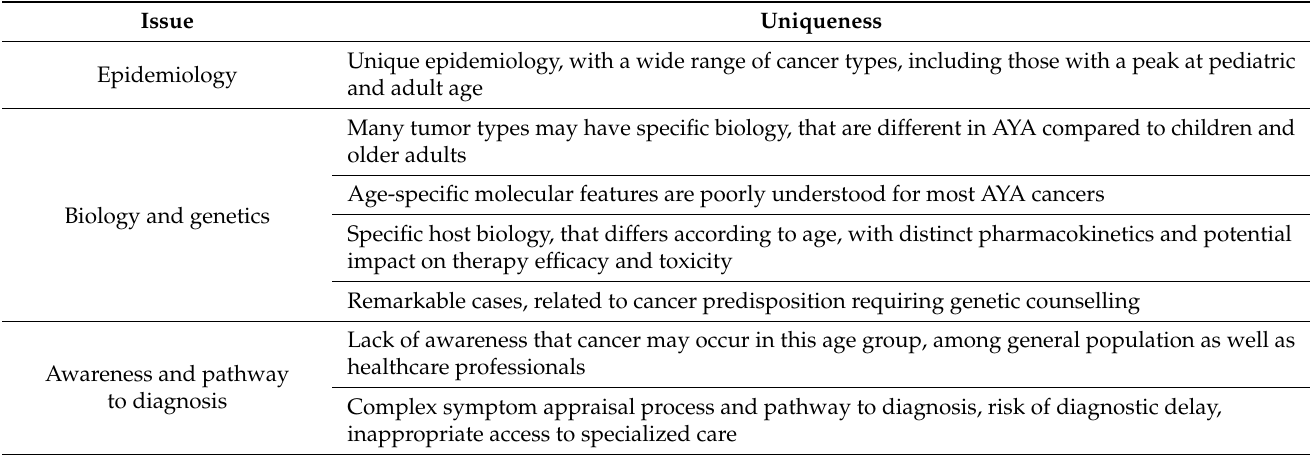
Table 1. Specific challenges of adolescents and young adults (AYA) with